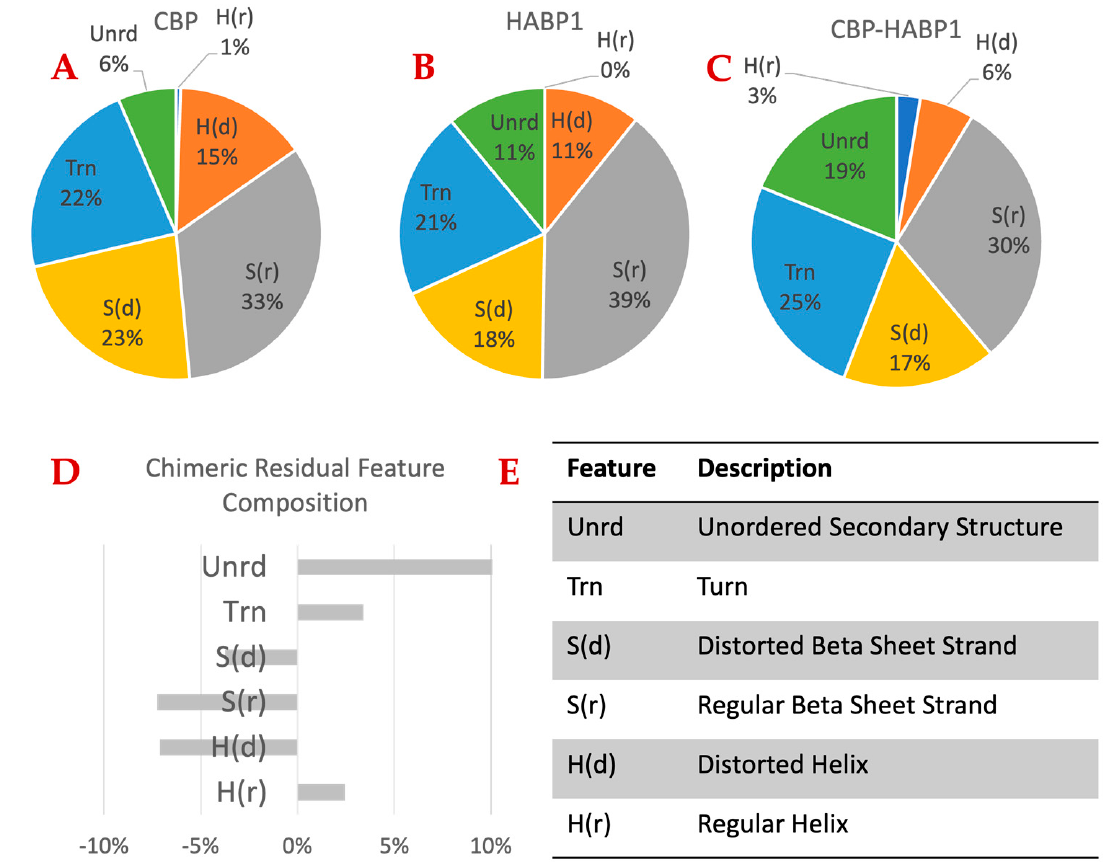
Figure 6. Circular dichroism additivity analysis comparing the average structure feature composition of among functional domains ( A , B ) to the chimeric peptide ( C ), which contains both functional domains and a 3-amino acid spacer. The residuals given in ( D ) are the difference between the feature composition from CD analysis and the average feature composition of the two domains. ( E ) Legend of feature descriptions in ( A − D ). The chimeric peptide has about 10% more unordered structure than expected from the average of the functional domains. This loss of ordered structure seems to come mainly from the loss of regular beta sheet strand (S(r)) and distorted helix (H(d)).